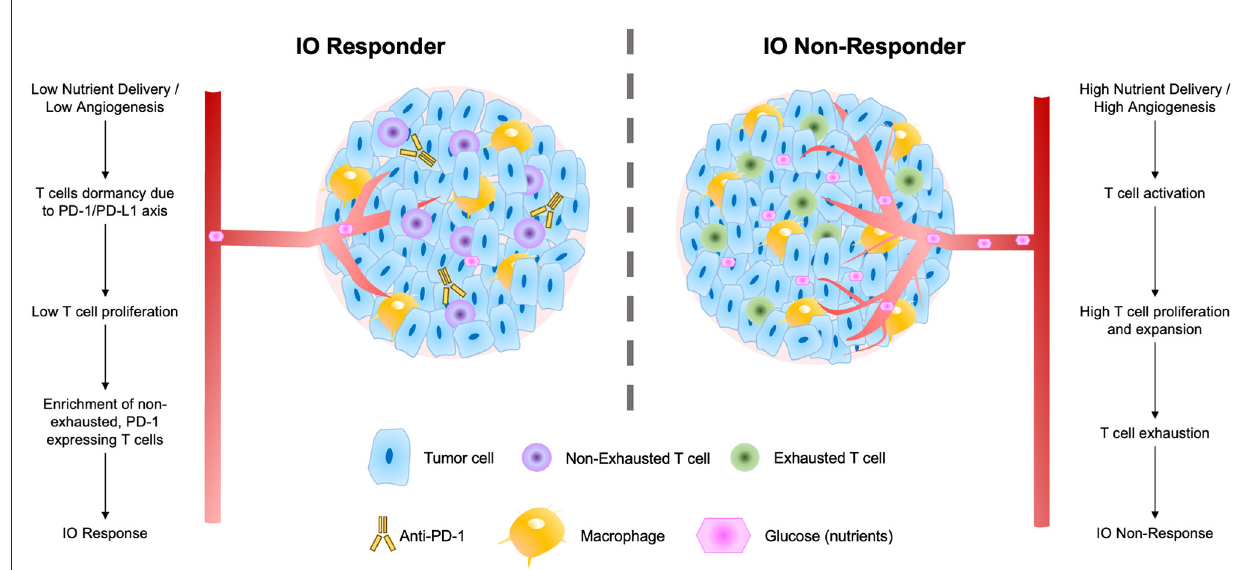
FIGURE7 Schematic of factors contributing to tumor IO-sensitivity (left) and IO-insensitivity (right) both within tumors and within the local tumor microenvironment. These factors include degrees of nutrient delivery, T cell dormancy, T cell proliferation, and levels of exhaustion in local T cell